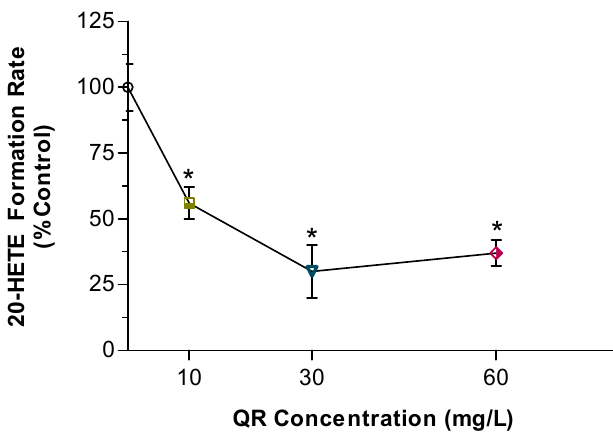
Figure 4. Effect of QR on the rate of 20 ‐ HETE formation in rat kidney microsomes. Mean 20 ‐ HETE concentration from rat kidney microsomes ( n = 8/group) treated for 7 weeks with QR in drinking water at different concentrations, expressed as the percentage of the control group . All groups were compared using one ‐ way ANOVA followed by multiple comparisons. * Significant difference from control with p < 0.05.